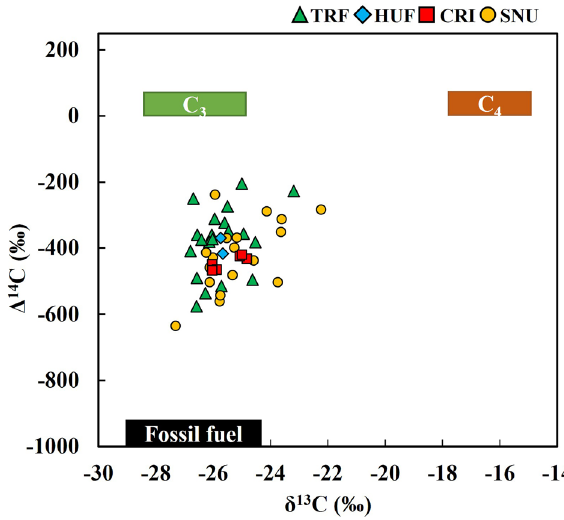
Figure 2. Isotopic source diagram for the PM 2.5 samples. The black, green, and brown bars indicate three endmembers including fossil-, C 3 plants-, and C 4 plants-derived carbon,